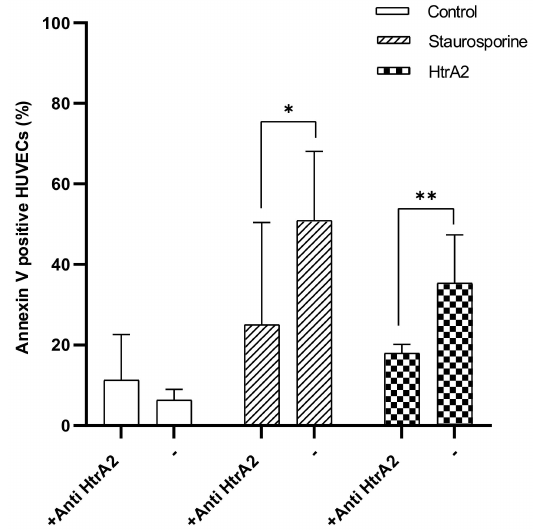
Figure 4. Anti-HtrA2 antibodies partially inhibited extracellular HtrA2 and staurosporine-induced apoptosis. HUVEC cultures were incubated in n the presence and absence of staurosporine (200 nM), HtrA2 (2 µ g / mL) and anti-HtrA2 (2 µ g / mL). The percentage of apoptotic HUVECs was determined after 2 h by Annexin V staining. Results are presented as means with S.D that are significantly di ff